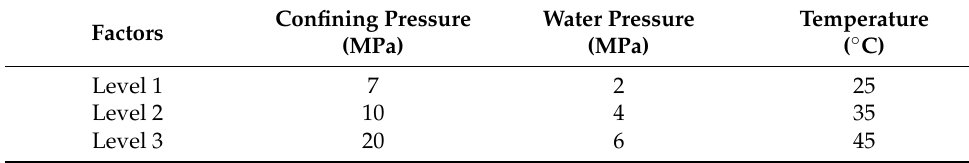
Table 4. Three factors and three levels of the orthogonal